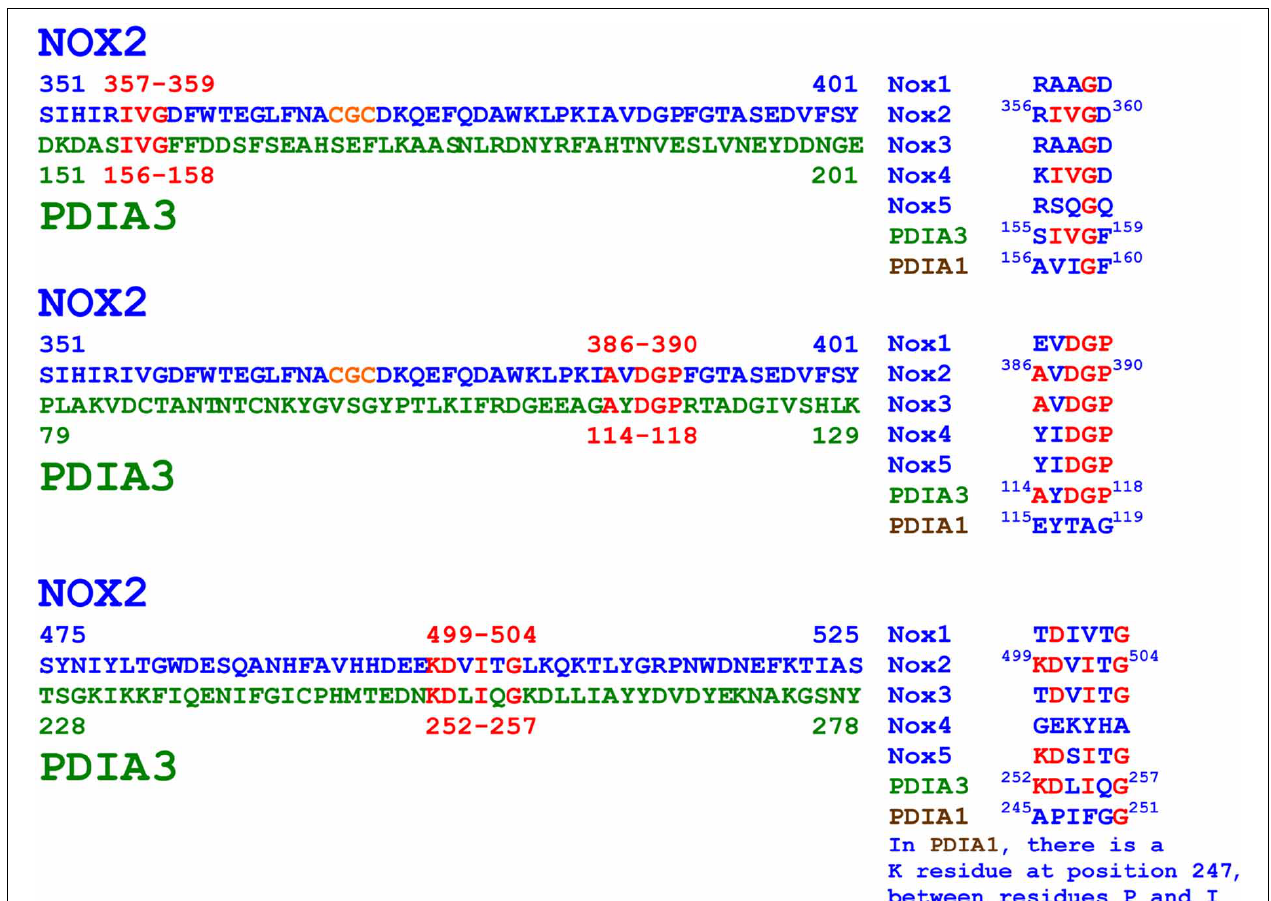
FIGURE 8 | Amino acid sequence similarities between the dehydrogenase region of Nox2 and PDIA3. The figure illustrates three small regions (3–6 residues) exhibiting partial sequence identities between Nox2 and PDIA3. The representation of the motifs in non-phagocytic Noxes (Noxes 1, 3, 4, and 5) is also shown. Monoclonal anti-Nox2 antibody 54.1 recognizes Nox2 residues 381 KLPKIAVDGP 390 and might recognize PDIA3 residues 114 AYDGP 118 (see Figure 9A ). Monoclonal anti-Nox2 antibody NL7 recognizes Nox2 residues 498 EKDVITGLK 506 and might recognize PDIA3 residues 252 KDLIQG 257